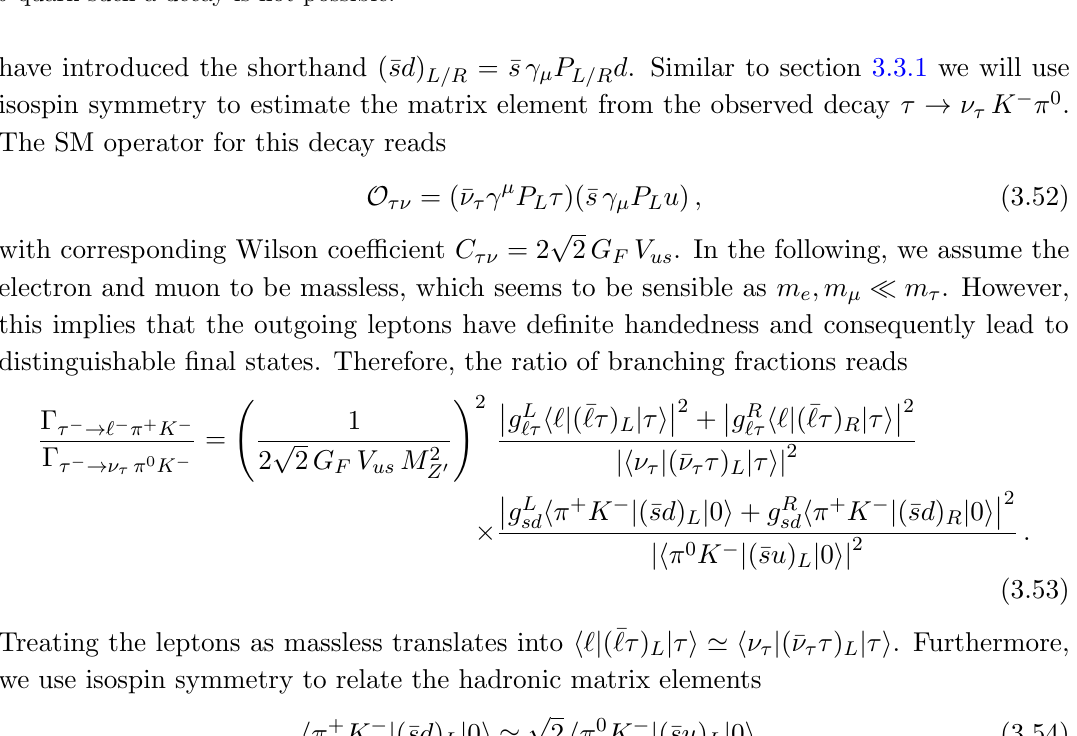
Figure 14 . Diagrams of a possible signature of a doubly (cid:13)avor-changing Z 0 boson with non-zero couplings in the sd and e(cid:28)=(cid:22)(cid:28) sector ( q denotes either a d - or a u -quark). The resulting decays are (cid:28) (cid:6) ! ‘ (cid:6) ( (cid:25) 0 K 0 =(cid:25) (cid:6) K (cid:7) ), where ‘ 2 f e; (cid:22) g . Only in the sd sector such a semi-leptonic (cid:28) decay into a pion and a kaon is kinematically allowed. Especially for a non-zero quark coupling involving a b -quark such a decay is not